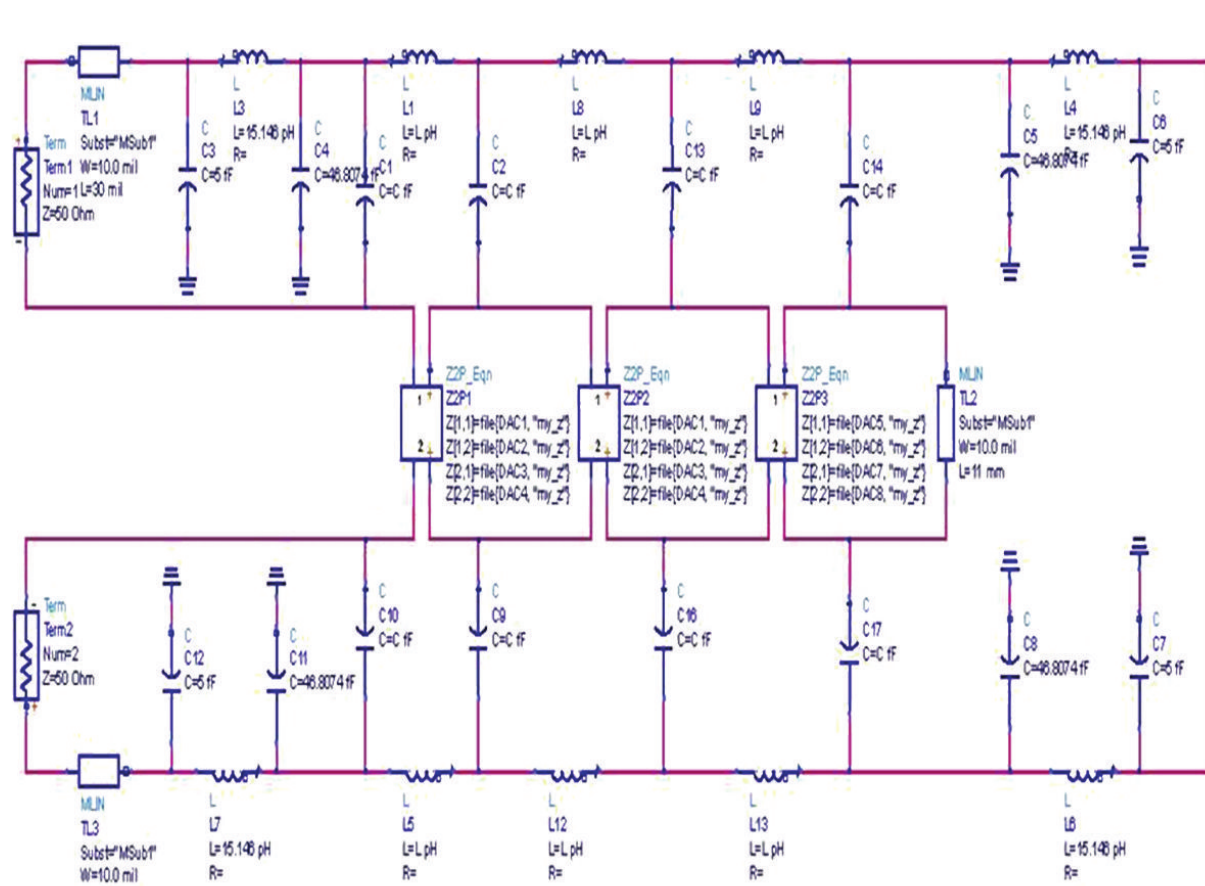
Figure 27: Equivalent circuit of via